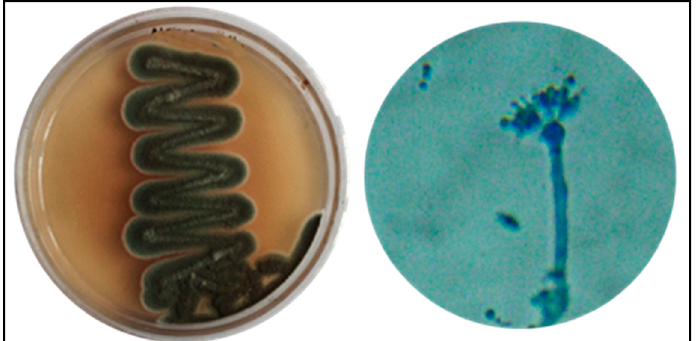
Figure 1. Morphology of P. oxalicum LA-1.